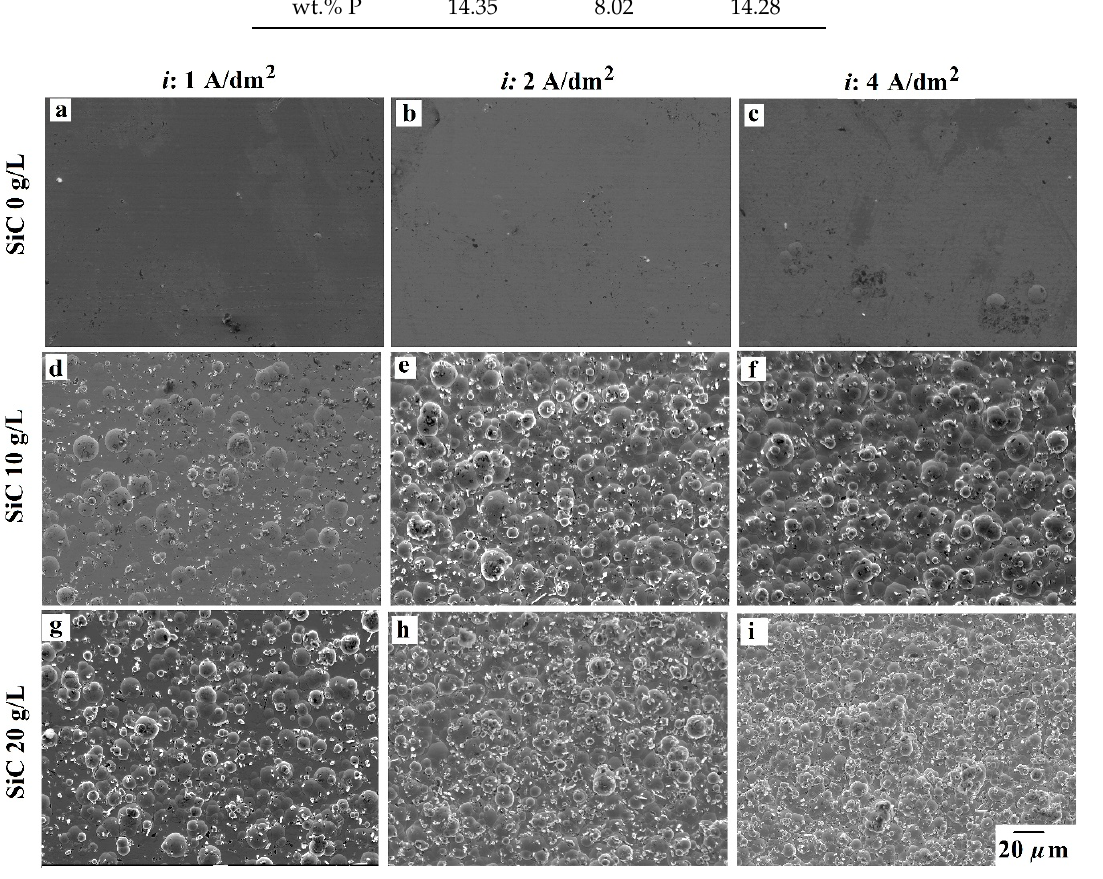
Figure 4. SEM images of the surface of ( a – c ) NiP, ( d – f ) NiP/10SiC, ( g – i ) NiP/20SiC. ( a , d , g ) i : 1 A/dm 2 ,